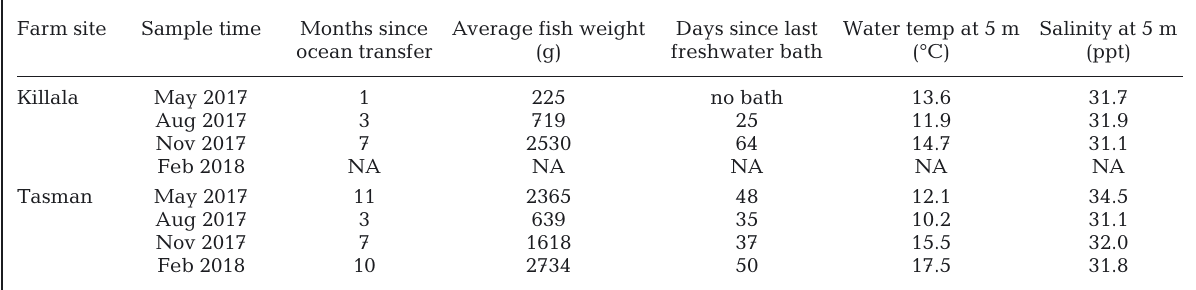
Table 1. Case history of sampled Atlantic salmon. NA: no samples could be collected at that sampling event